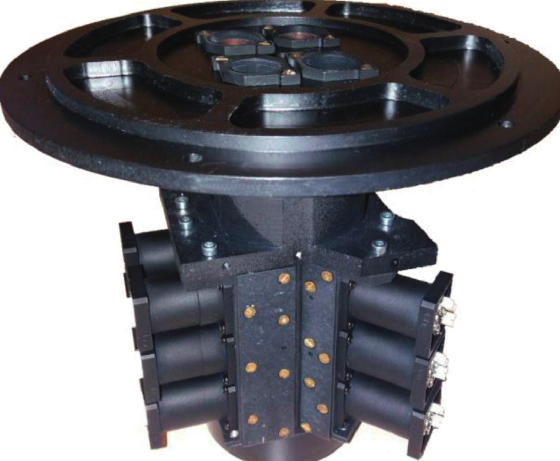
Figure 14: General view of the PSA